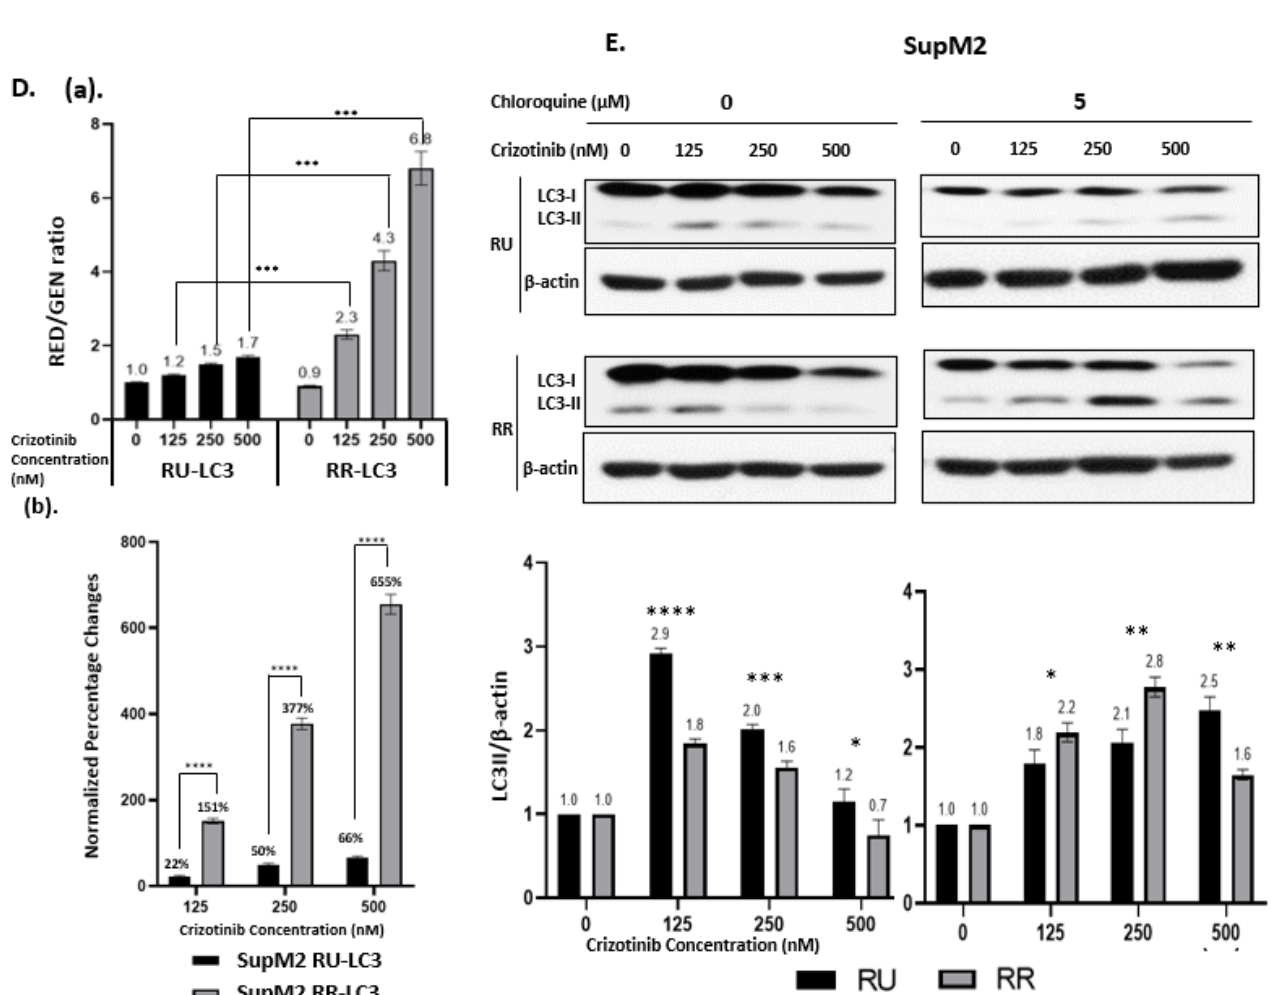
Figure 1. Crizotinib-induced autophagy activity is significantly enhanced in Reporter Responsive (RR) cells than Reporter Unresponsive (RU) cells. ( A ) RED/GEN ratio in LC3 transduced SupM2 RU and RR subset cells. SupM2 RU cells were used as the baseline of GEN and RED. ( B ) Western blotting analysis to confirm the transduction of exogenous LC3 in SupM2 RU and RR cells. The bands at 36 kDa were exogenous LC3 fused with fluorescent probes. ( C ) Confocal microscopy was performed to verify the expression of exogenous LC3. RU-LC3 and RR-LC3 at the steady state showed the co-expression of both red and green fluorescence signals; cells were visualized with phase contrast. ( D ) ( a ) RED/GEN ratio in SupM2 RU-LC3 and RR-LC3 cells following treatment with 0, 125, 250, and 500 nM of crizotinib. Cells were collected for flow cytometry measurement after 24 h. ( b ) Data provided in A is expressed as percentages of change for each crizotinib dosage. Data normalized to control dimethyl sulfoxide (DMSO/Crizotinib at 0 nM) group, respectively. ( E ) Changes in LC3 protein level in response to crizotinib are different between RU and RR cells. Western blot analysis of SupM2 RU and RR cells treated with different dosages of crizotinib (0, 125, 250, and 500 nM) with or without 5 µ M of chloroquine for 24 h. Original blots are shown in Figure S4. ImageJ Software was used to measure bands intensity. Three independent experiments were performed. Data shown as mean ± standard deviation (SD), n = 3, * p < 0.05, ** p < 0.01, *** p < 0.001, **** p < 0.0001, Student’s